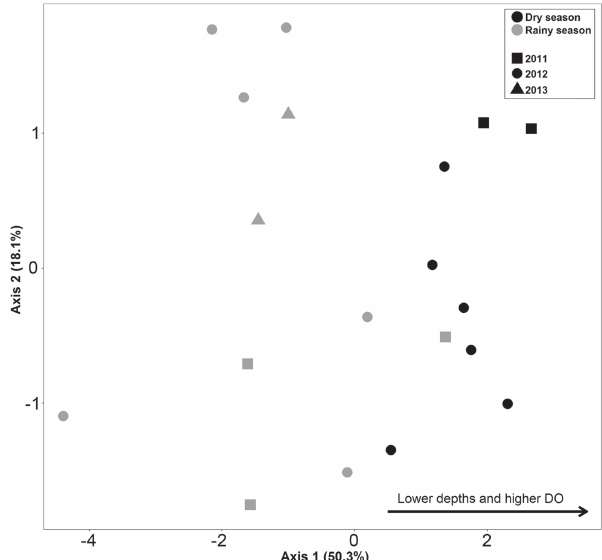
Fig. 2. Principal Components Analysis (PCA) with abiotic variables measured monthly between September 2011 and February 2013 in the lower Paraíba do Sul River. Main correlations of abiotic variables and selected axis are highlighted. Ninety-nine percent of the fish larvae were caught in the rainy season (from October through March). The ichthyoplankton composition also differed significantly between hydrological seasons (R² = 0.11; p = 0.001).